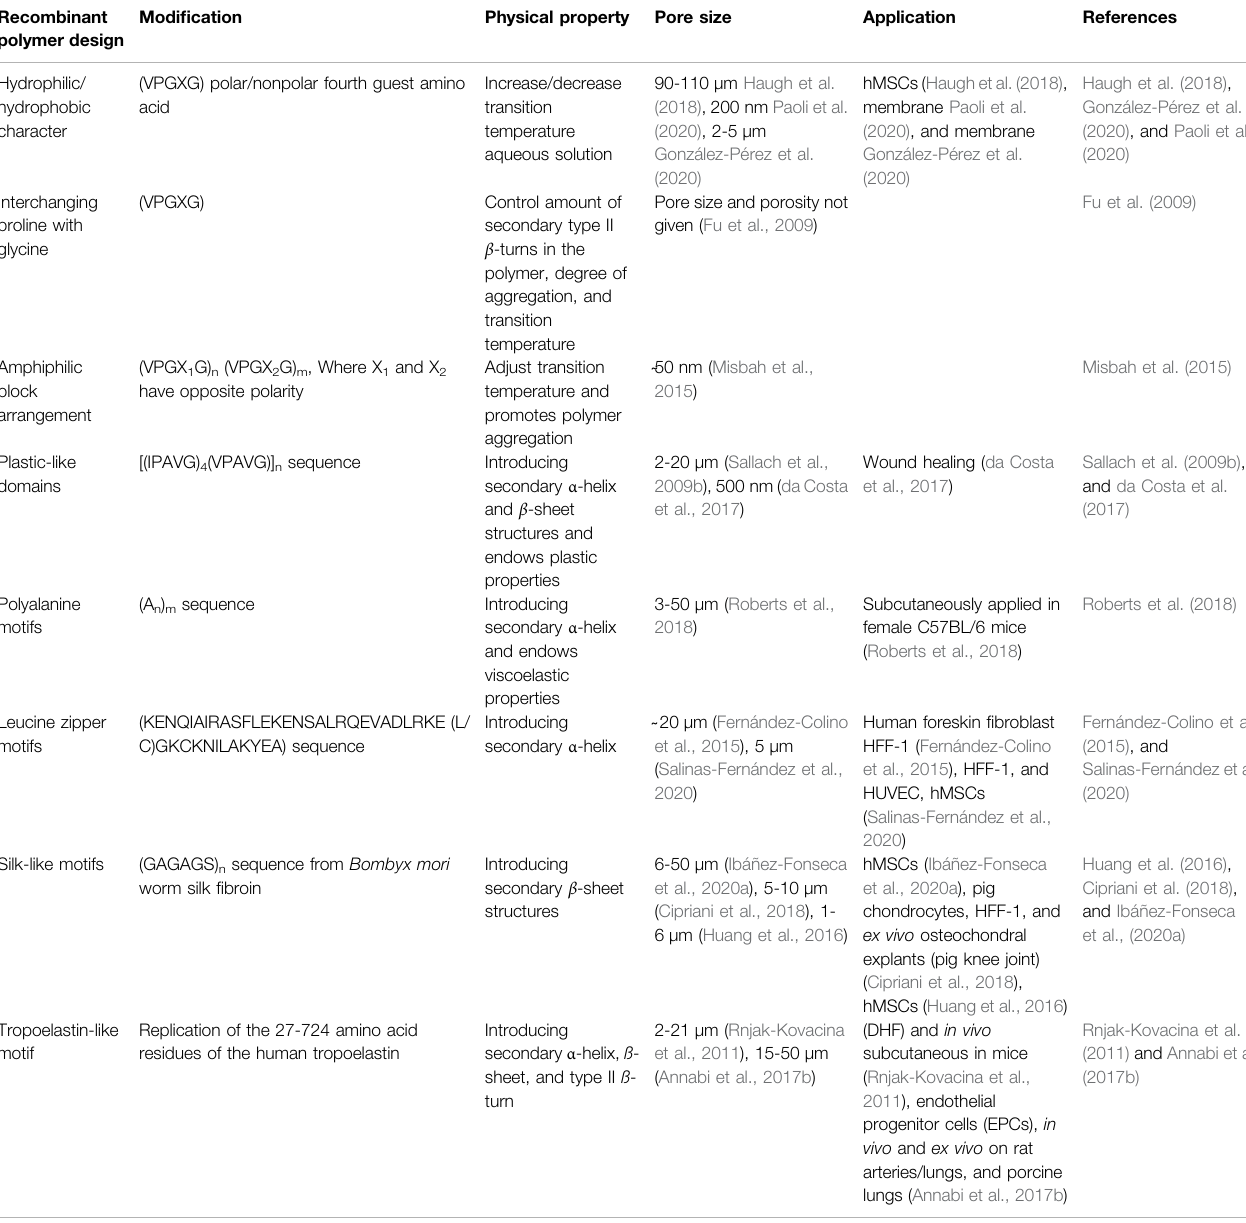
TABLE 2 | Common approaches used to control polymer physicochemical properties for porous scaffold